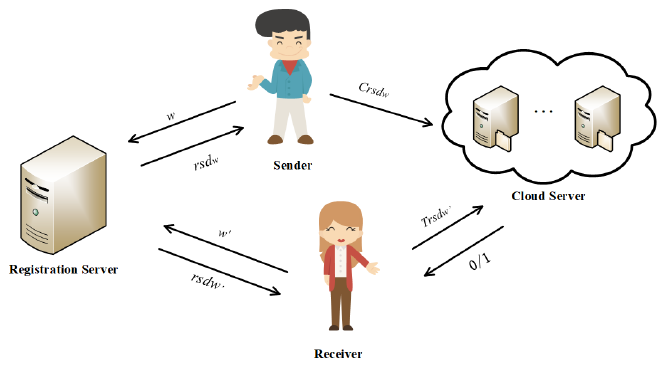
Figure 1. System Model of